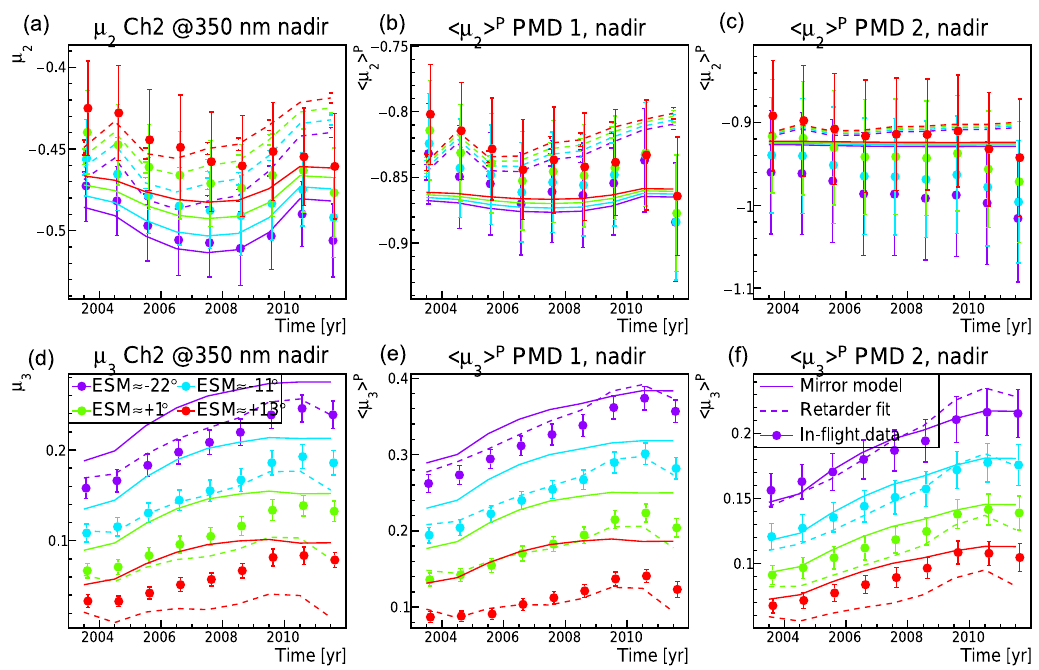
Figure 16. Time dependence of in-flight end-to-end Mueller matrix elements µ 2 (a, b, c) and µ 3 (d, e, f) for nadir for four selected ESM angles from measurements (data points), the scan mirror model without the retarder (solid lines) and the mirror model with the retarder (dashed lines). The error bars of the data include statistical and total systematic errors. (a, d) Channel 2 feature; (b, e) PMD 1; (c, f) PMD 2.The color code signifies the ESM scan angle bin ( − 22, − 11, + 1, + 13 ◦ ), increasing on a rainbow color